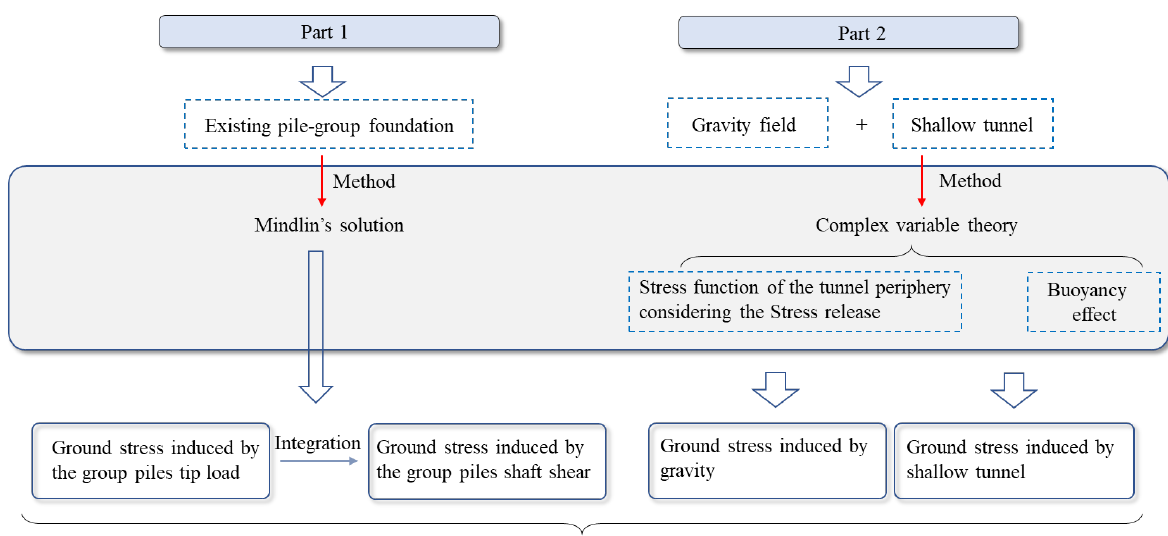
Figure 2. Flowchart of the